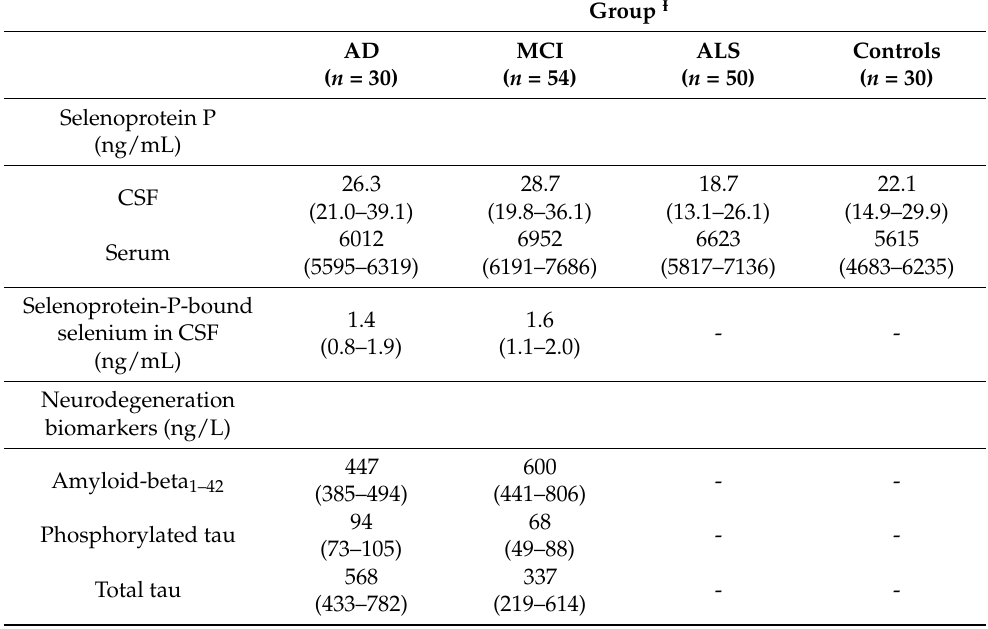
Table 1. Cerebrospinal fluid (CSF) and serum levels of selenoprotein P and CSF levels of selenoprotein-P-bound selenium, amyloid-beta and phosphorylated and total tau in relation to diagnosis.